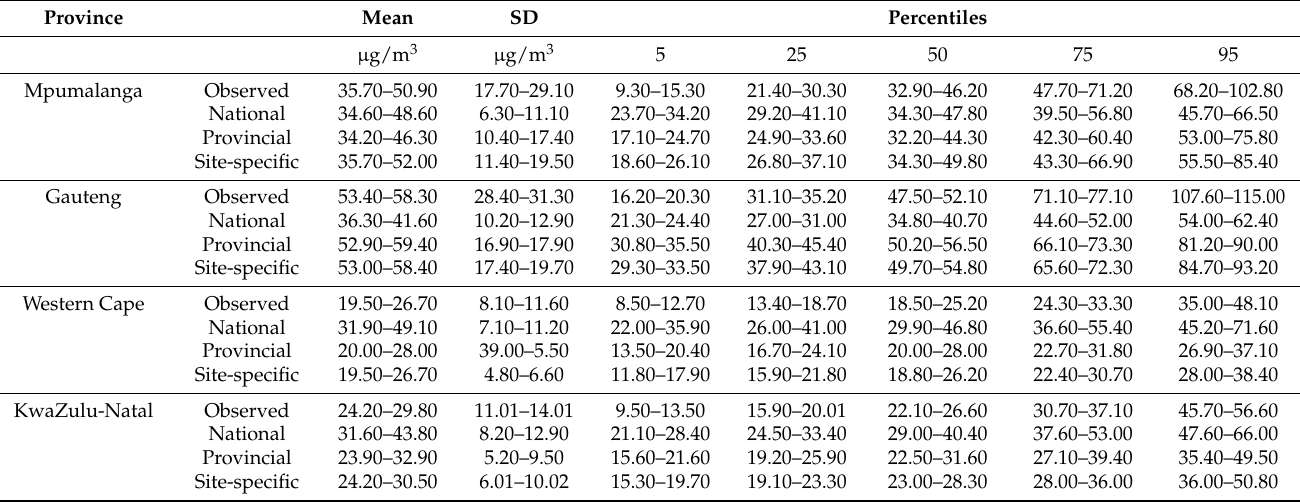
Table 3. Range of the observed versus predicted PM 10 concentrations (in µ g/m 3 ) for the 3 different models (National, Provincial and Site-specific) averaged over all sites and years (2010–2017) by province for the mean, standard deviation (SD) and 5th, 25th, 50th, 75th and 95th